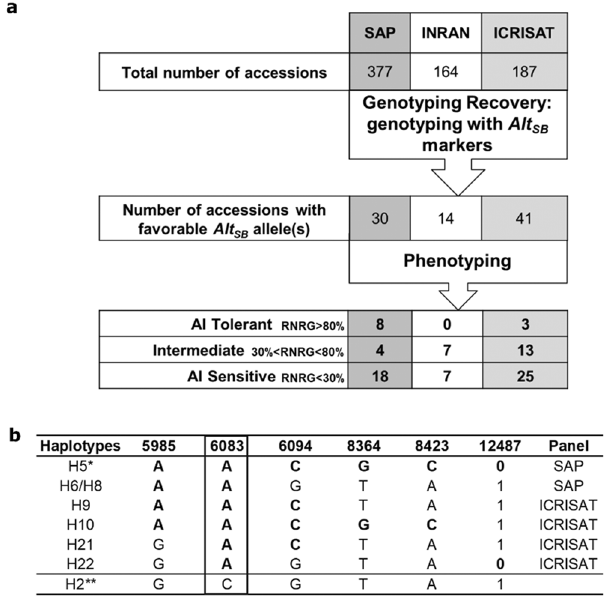
Figure 4. Allele mining in the SAP, INRAN and ICRISAT panels. ( a ) Diagram depicting the allele mining procedure in the SAP, INRAN and ICRISAT panels, which were used to identify accessions harboring at least one favorable Alt SB allele at marker loci, 5985, 6083, 6094, 8364, 8423 and 12487. The distribution of those accessions in classes of Al tolerance is shown. ( b ) Haplotypes of Al tolerant accessions and the Al sensitive line, BR007 (H2), included as reference. Alleles in bold are linked in coupling with Al tolerance 27 . The reference Al tolerant and Al sensitive haplotypes from SC283 (H5) and BR007 (H2), which is possibly an ancestral haplotype 27 , are marked with single and double asterisks, respectively. Al tolerance was assessed via Al inhibition of root growth (relative net root growth, RNRG) in nutrient solution containing {27} µ M Al 3 + at pH 4.